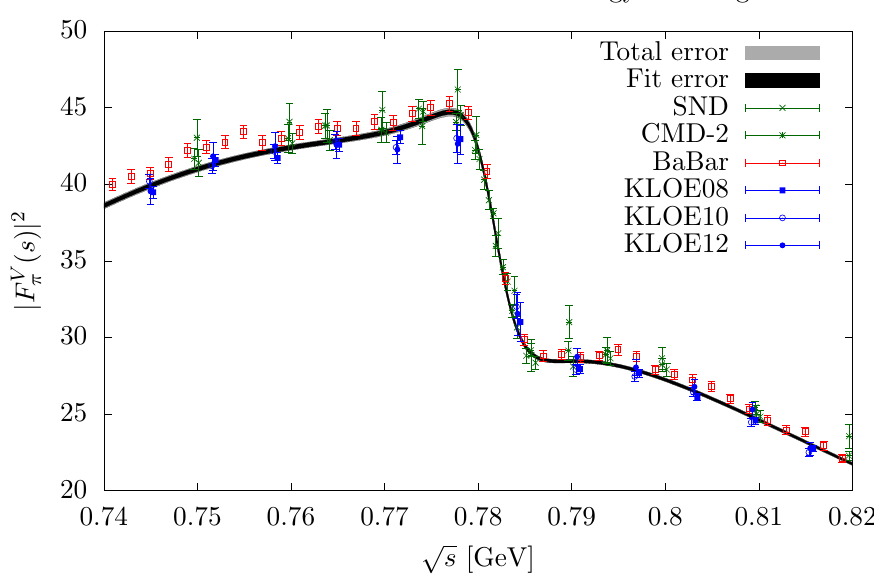
Figure 10. Fit result for the pion VFF in the (cid:26) { ! interference region, together with the e + e (cid:0) data sets. The data points are shown with the energy rescaling (4.10) and the curve is the (cid:12)t result with (4.14) for the ! mass.